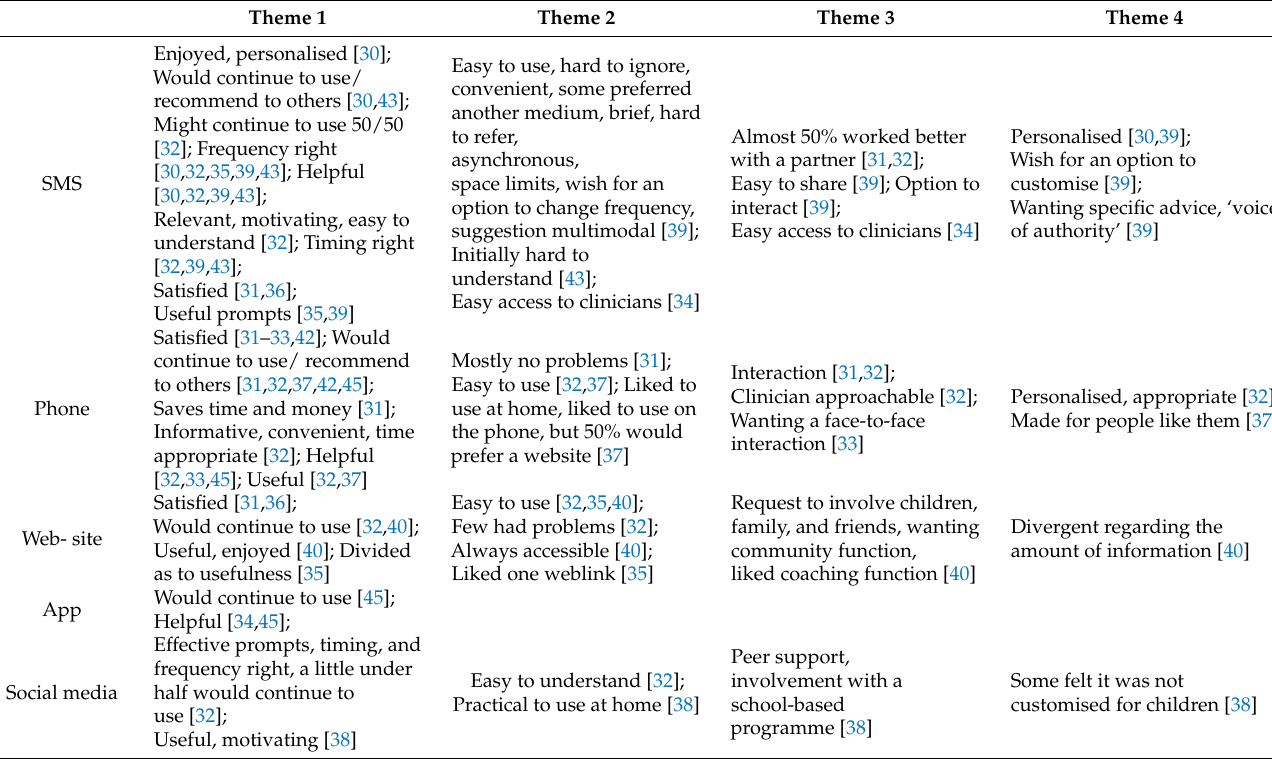
Table A3. Summary of